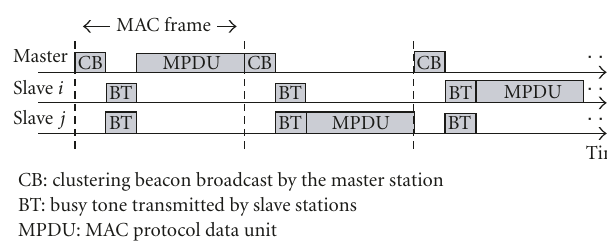
Figure 1: Clustering + MAC